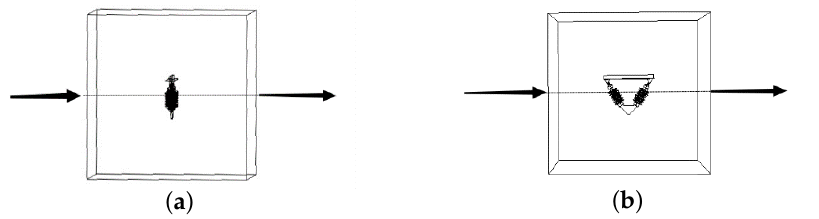
Figure 7. Schematic diagrams under different wind direction angles (horizontal wind). ( a ) 0 ◦ wind direction angle; ( b ) 90 ◦ wind direction angle (wind elevation of 0 ◦ ).